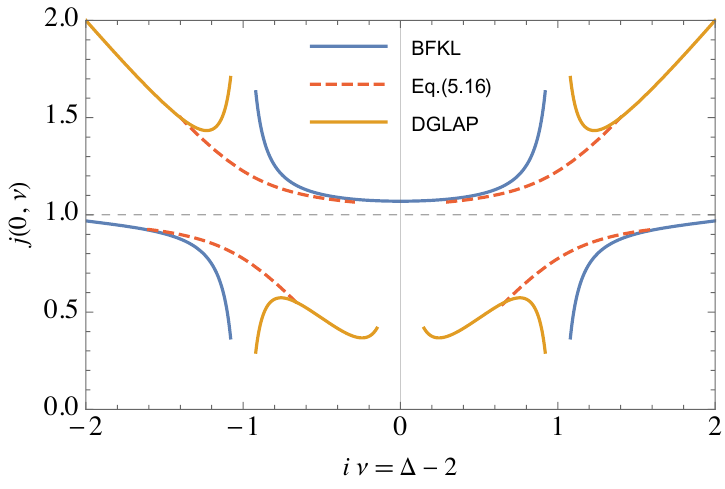
Figure 6 . Level repulsion between the Pomeron and DGLAP trajectories for m = 0 as a function of scaling dimension, illustrating the (cid:23) = (cid:6) i singularities. (LO expressions plotted with (cid:21) = g 2 = 1.)